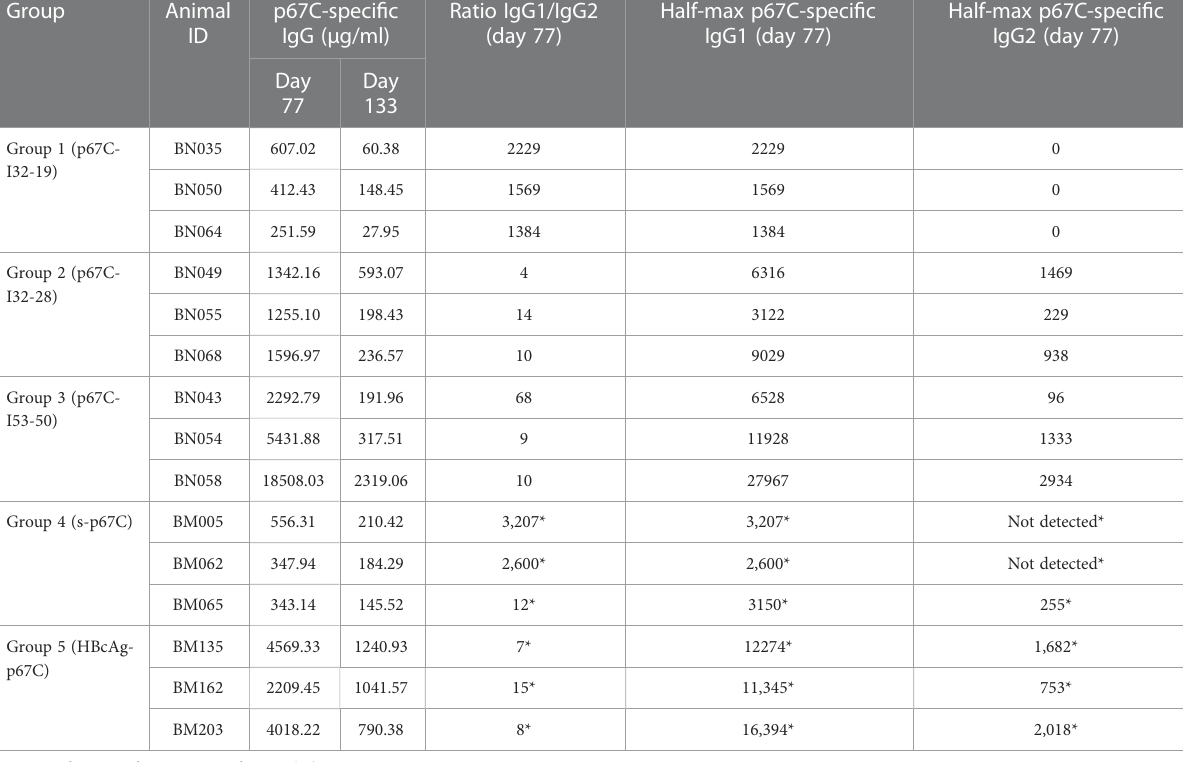
TABLE 2 Summary of antibody titers for immunogenicity studies in cattle.